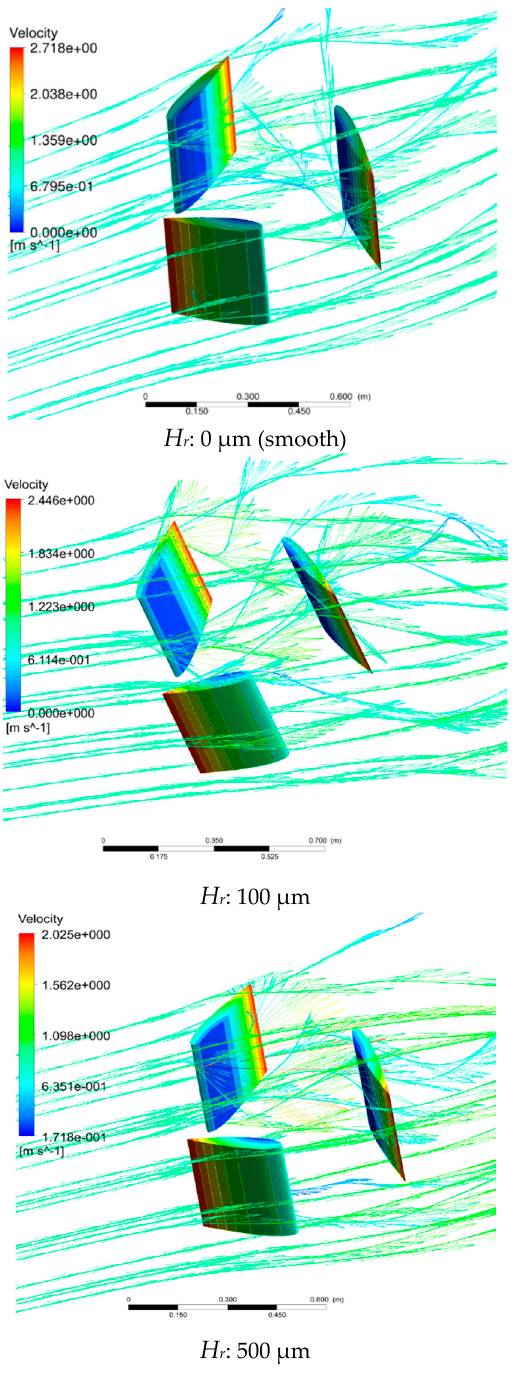
Figure 10. Velocity vectors in various roughness heights at ζ = 1.5 and angle of 60°.